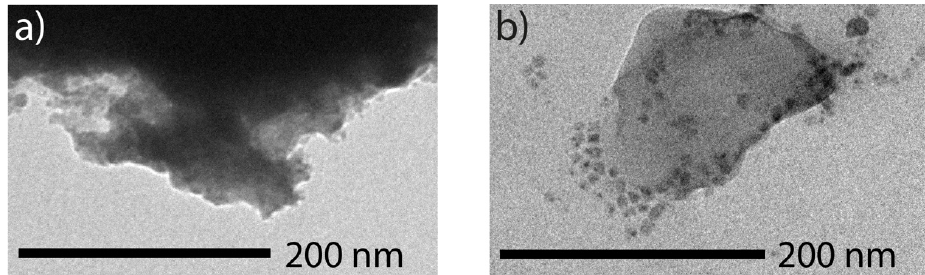
Figure 8 . TEM images of NP Au ( a ) and the NC–NP Au hybrid structure ( b ). Figure 8. TEM images of NP Au ( a ) and the NC–NP Au hybrid structure ( b ).